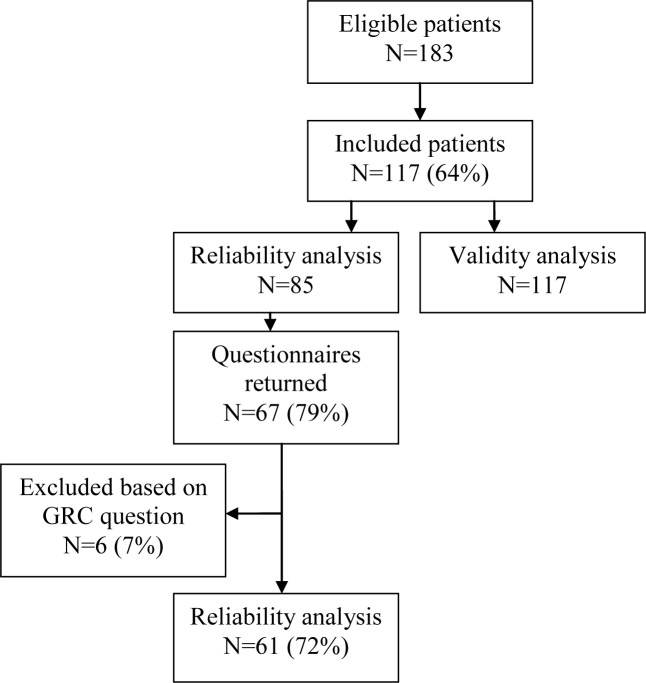
Flow diagram of inclusion of participants.Abbreviation: GRC, global rating of change.